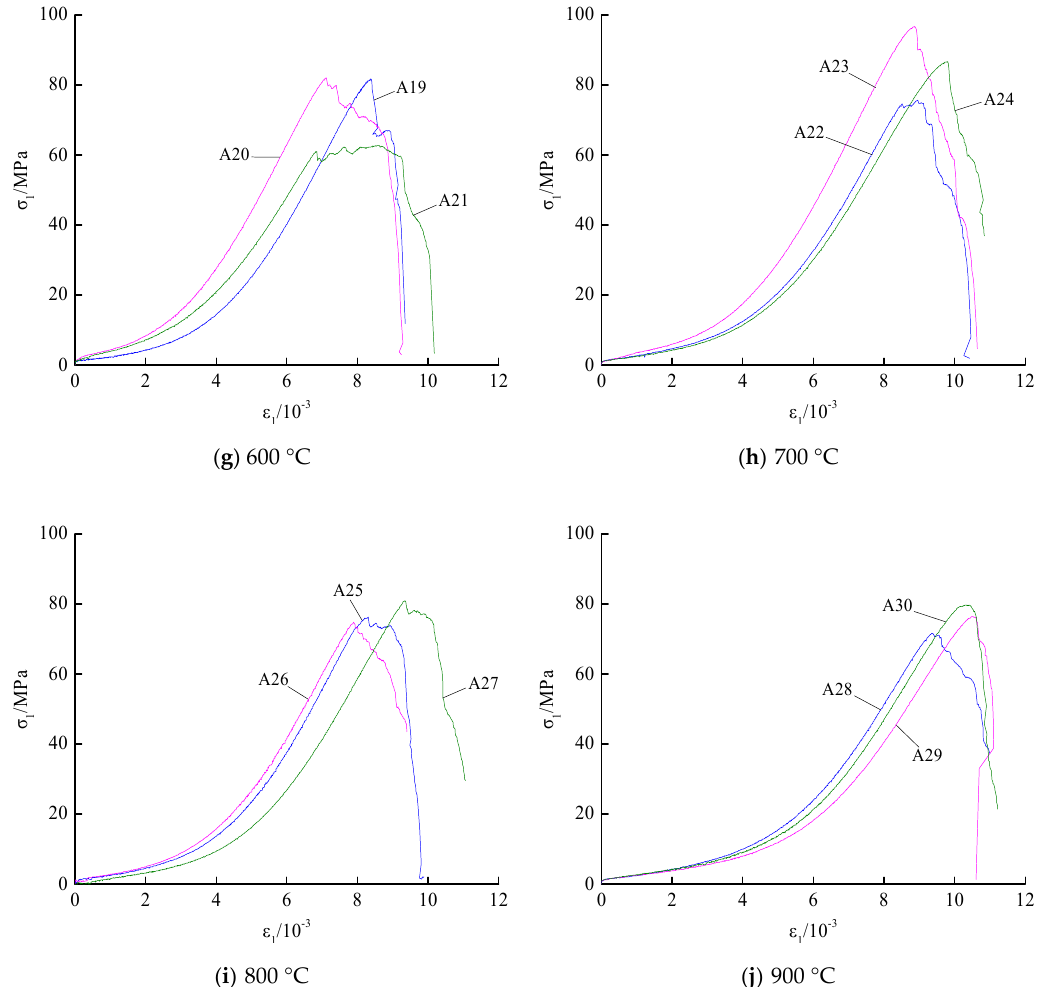
Figure 7. Complete stress–strain curves of samples under uniaxial compression. For comparison, Figure 8 shows the uniaxial compression of group A samples after 100~900 °C. The stress–strain comparison curve is obtained (one sample at the same temperature).